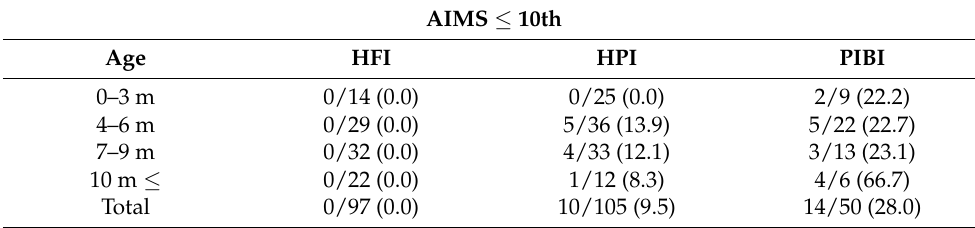
Table 3. Motor developmental delay using AIMS ≤ 10th by groups and ages.